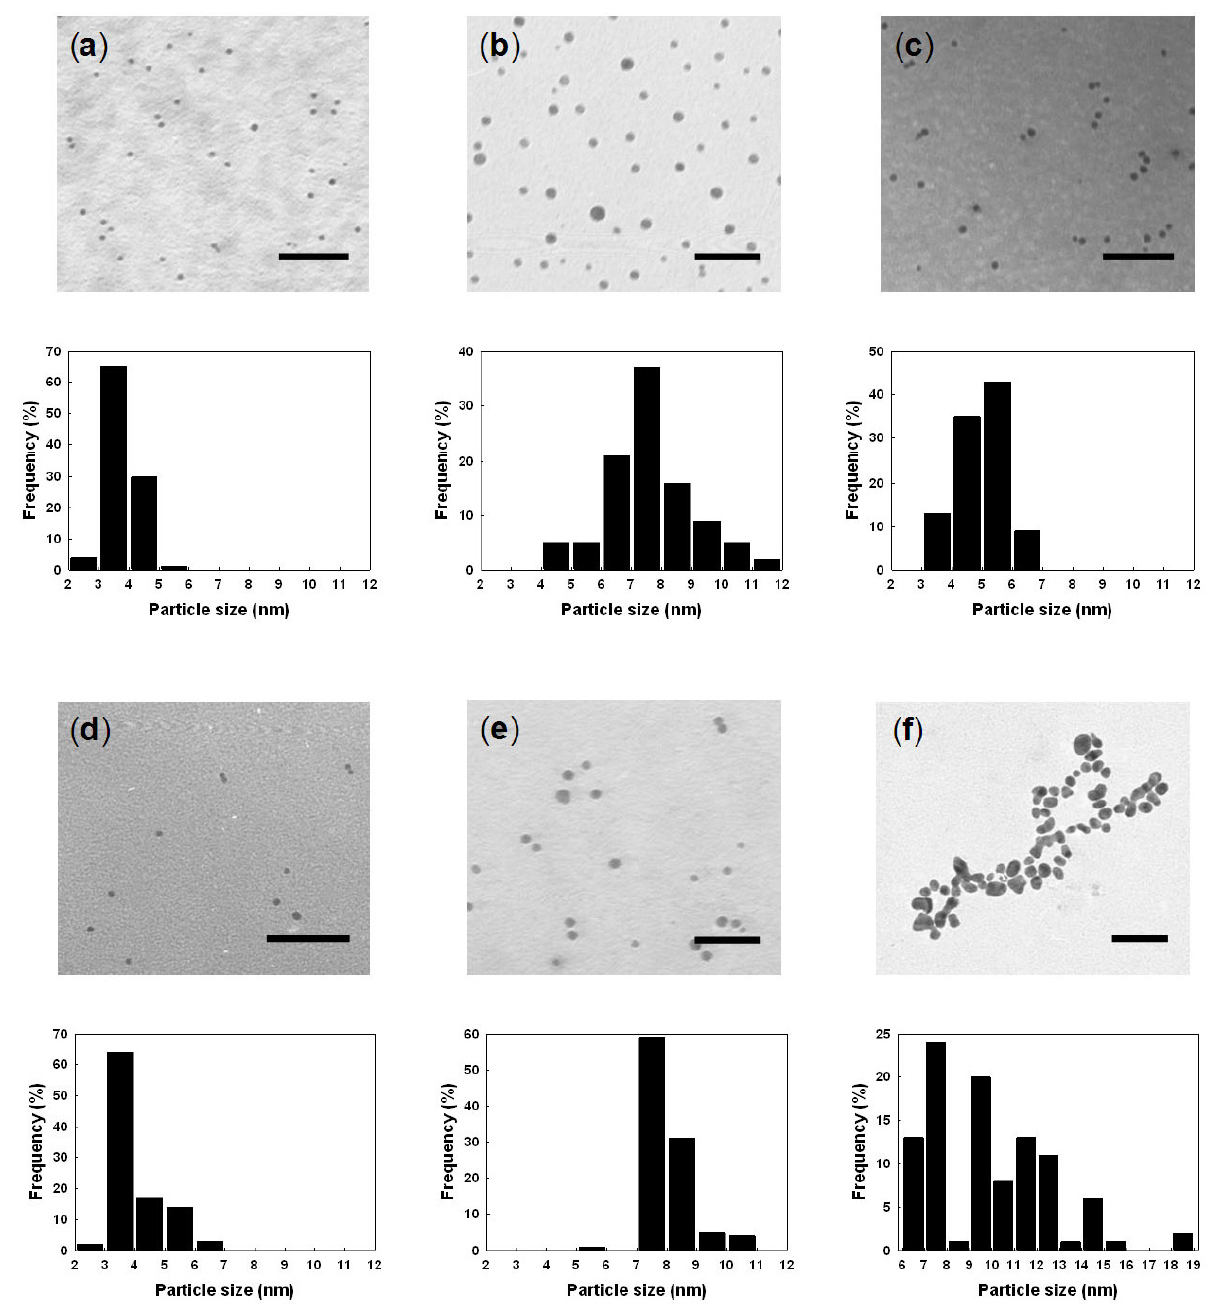
Figure 3. TEM images and size distribution histograms for various metal NPs @ TOCN composites, with molar ratios of Au:Pd = ( a ) 1:0; ( b ) 3:1; ( c ) 1:1; ( d ) 1:3; ( e ) 0:1 and ( f ) TOCN-free AuNPs. Scale bars correspond to 50